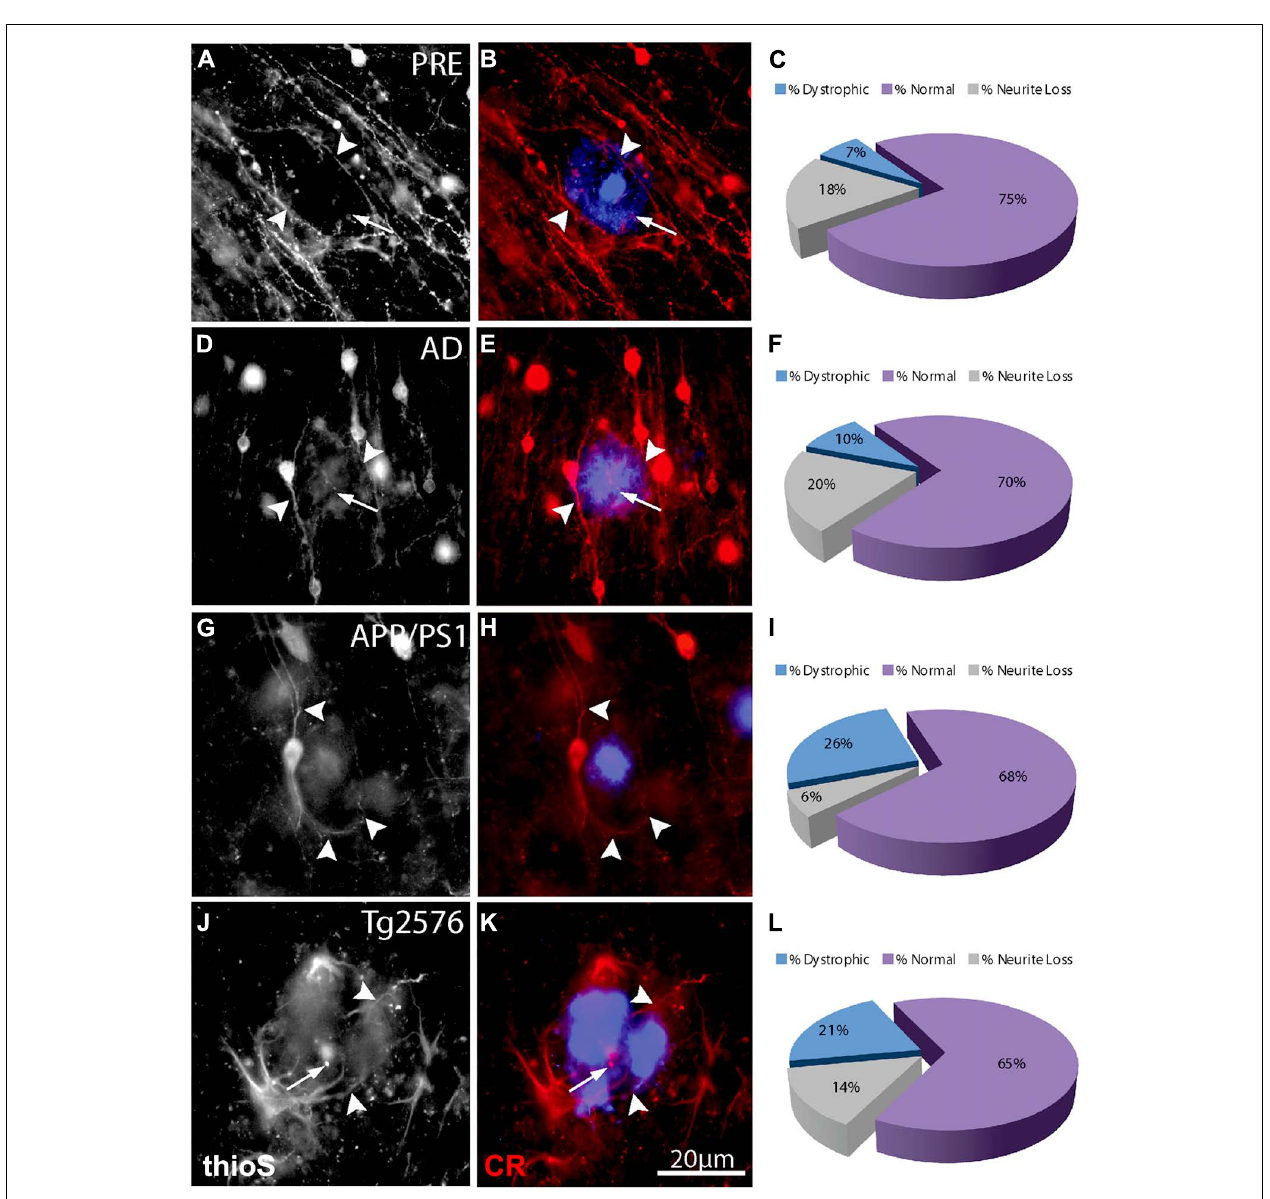
with thioflavin-S labeled fibrillar plaques. In most cases, these neurites appear to elaborate around plaques. A large proportion of CR-ir neurites associated with A β plaques are normal (purple fraction: C,F,I,L ) in all case types and there are comparatively fewer dystrophic neurites (blue fraction: C,F,I,L